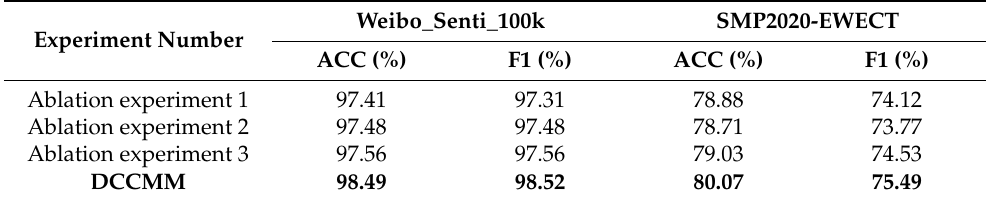
Table 7. Ablation experimental model performance